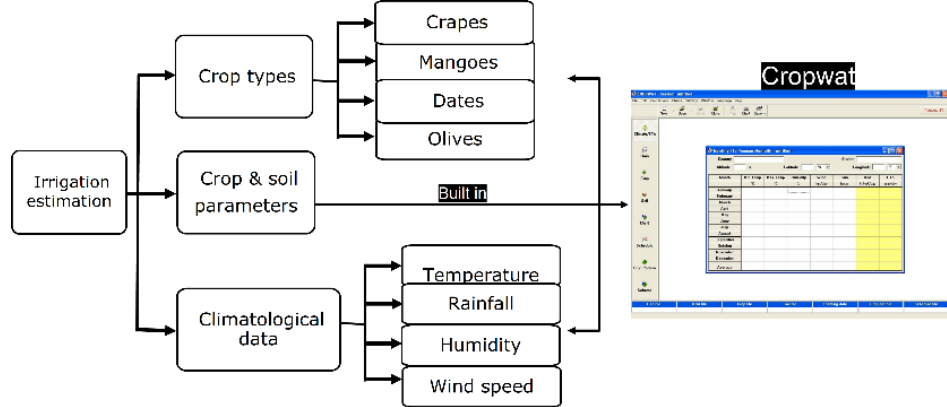
Figure 4. The datasets used to calculate the consumption rate of each crop type by Cropwat 8.